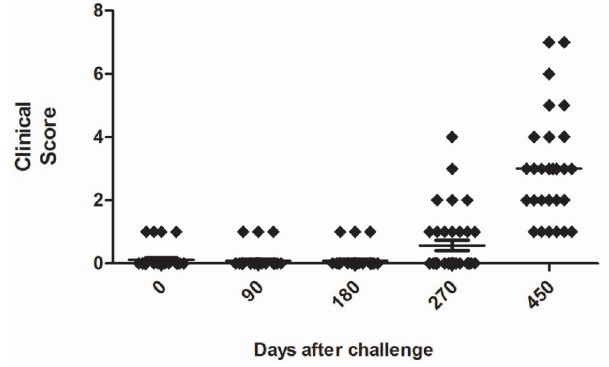
Figure 1. Clinical evaluation of infected dogs. Dog were intradermally infected with 10 7 parasites plus five pairs of Lutzomyia longipalpis salivary glands, through the infection (day zero to day 450 post infection) according the parameters described in Material and Methods section. The sum of parameters resulted in the clinical score shown in the